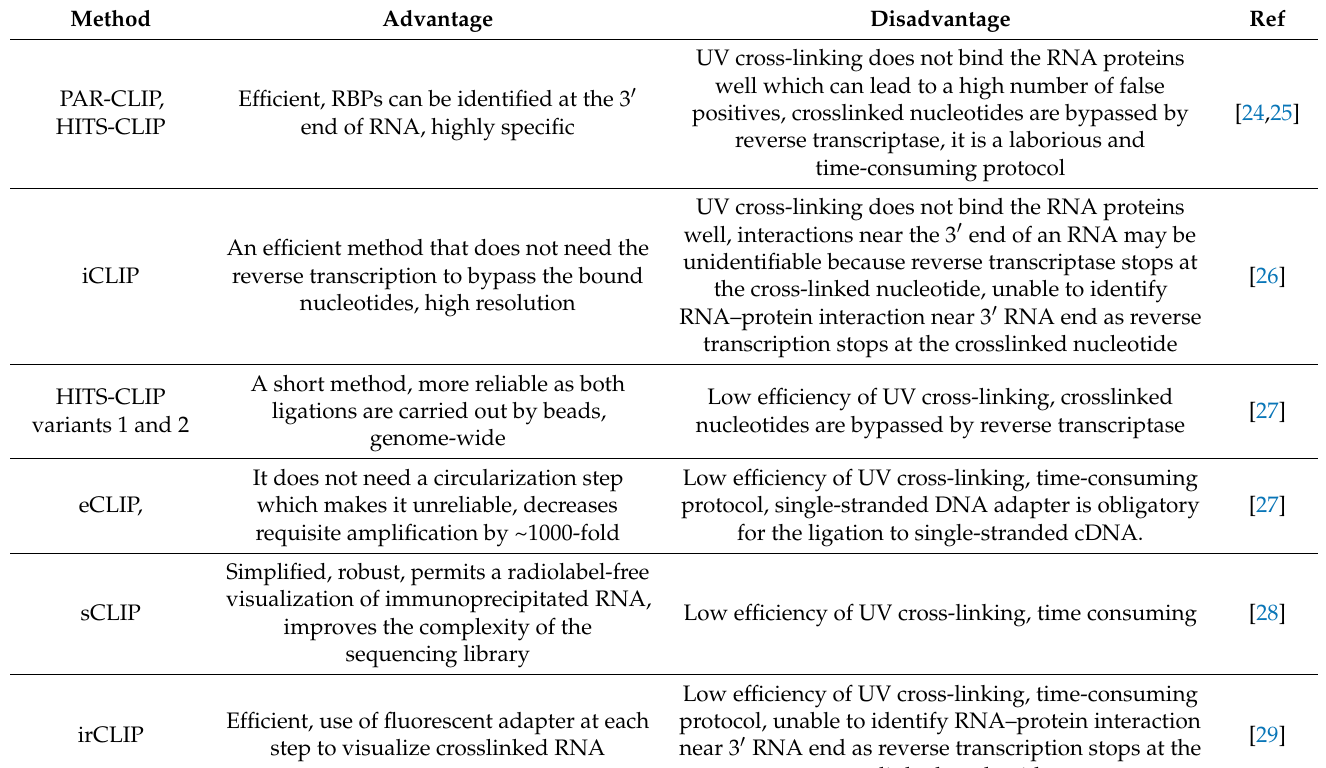
Table 1. Protein-centric approaches to find the targets of